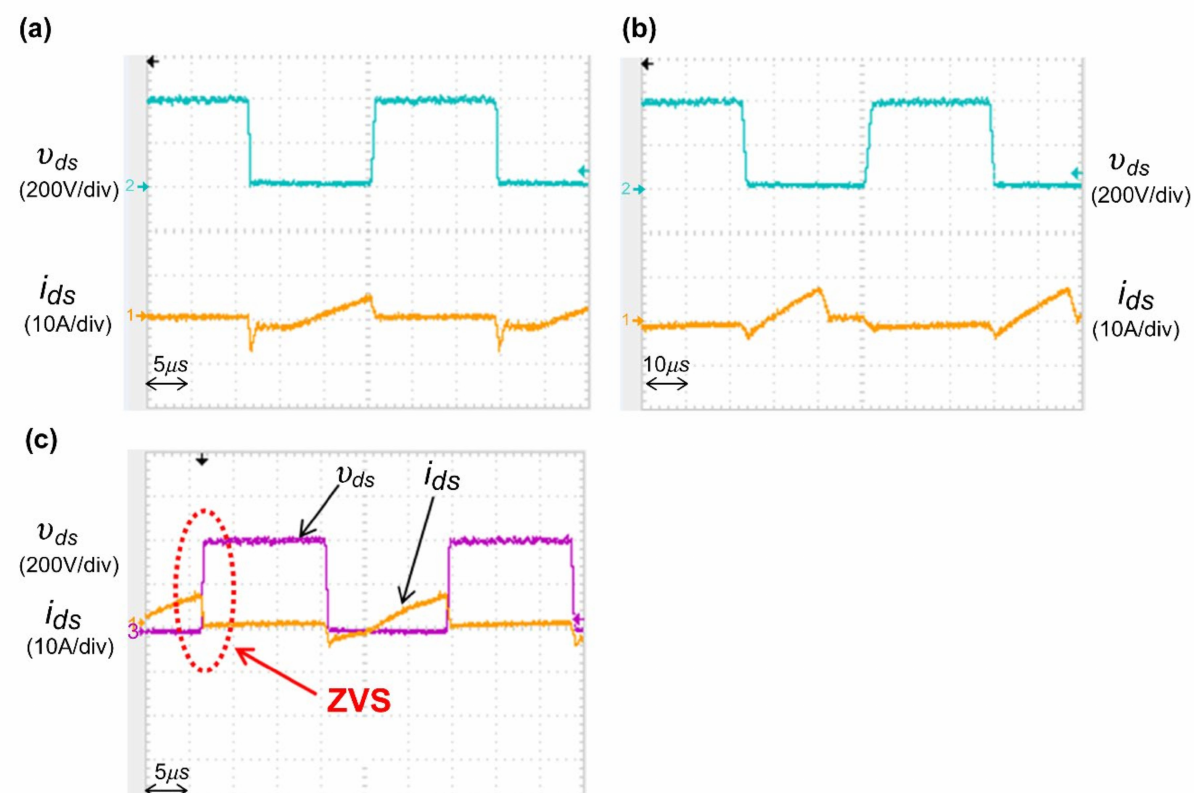
Figure 15. Waveforms of drain-source voltage and current, v GS , i ds , of switch S 1 : ( a ) half-load condition; ( b ) full-load condition; ( c ) ZVS